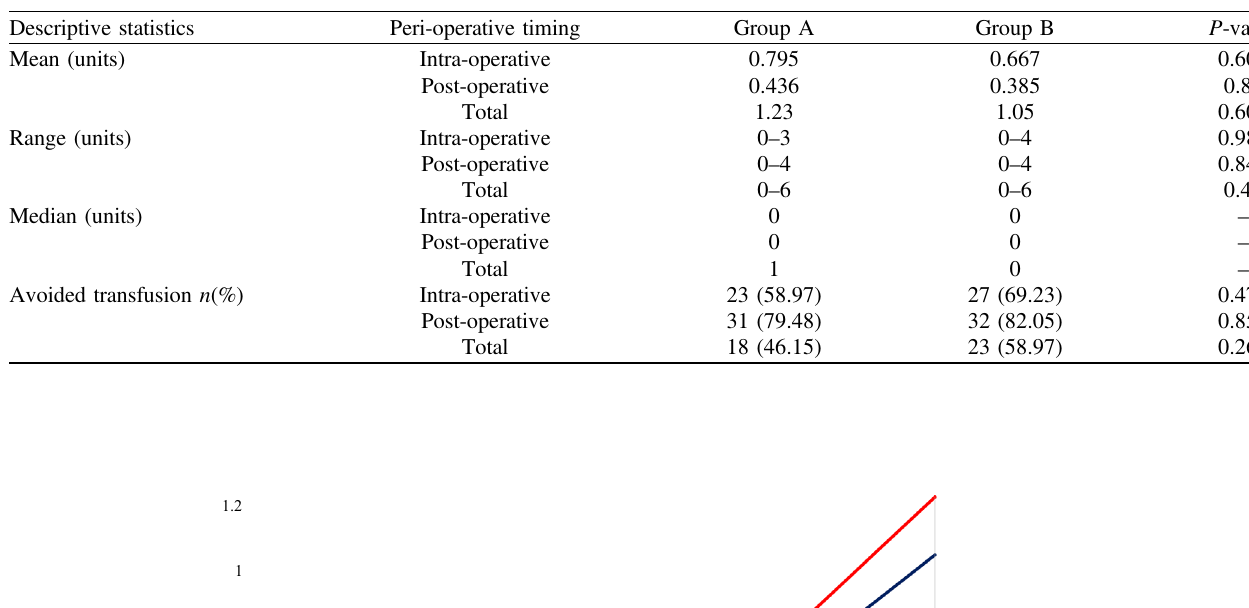
Table 1. Descriptive statistics of adult patients in terms of unit usage and transfusion avoidance.